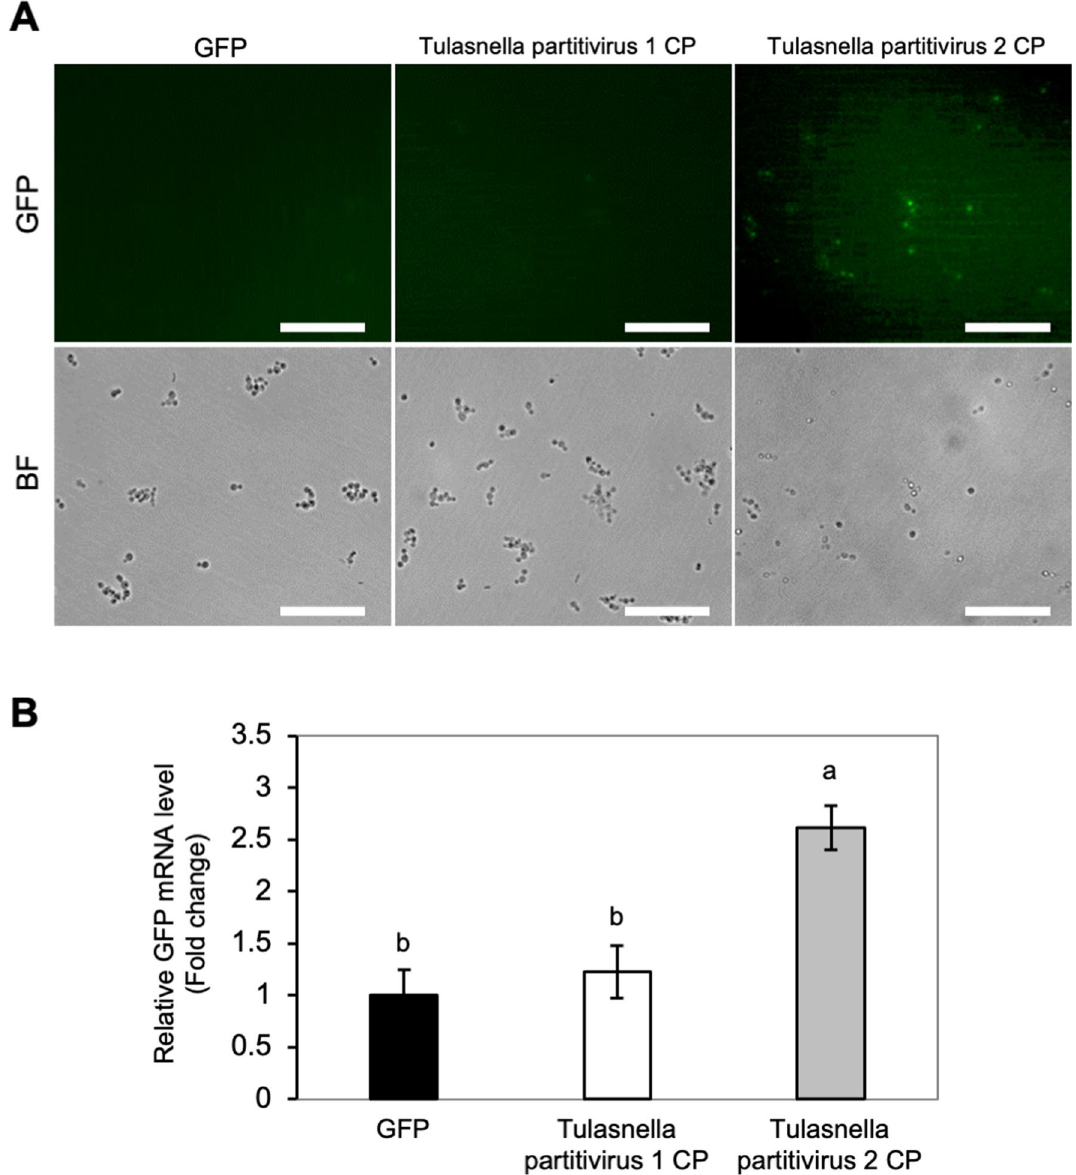
Figure 7. RSS activity of partitivirus CPs in Rhizoctonia protoplasts. ( A ) Micrographs of Rhizoctonia protoplasts expressing GFP and partitivirus CPs. Protoplasts of R. solani AG4-HG2 were co-transformed with pMF280-EGFP, CMV RNA4A harboring partitivirus CP and GFP dsRNA. Images were taken at 60 h after transfection using an epifluorescence microscope. Scale bars: 50 μm. ( B ) Relative GFP transcript accumulation levels in Rhizoctonia protoplasts. The GFP mRNA levels in the protoplasts were analyzed by real-time RT-PCR after 60 h. Ribosomal RNA was used as an internal control. Data were compared as values of fold-change relative to the control (GFP), and the values were analyzed on log-transformed data by Tukey’s multiple comparison test ( P < 0.05). Means and confidence intervals were shown in the graph. Different letters above each bar indicate significant